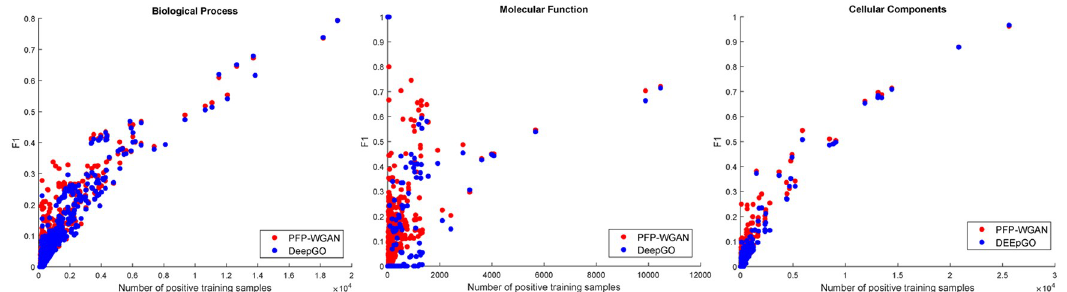
Fig 4. F1 obtained for PFP-WGAN and DeepGO-Seq for GO terms as a function of number of available positive training samples. The improvement which is obtained by PFP-WGAN for rare terms is more considerable comparing to terms with large numbers of positive samples.